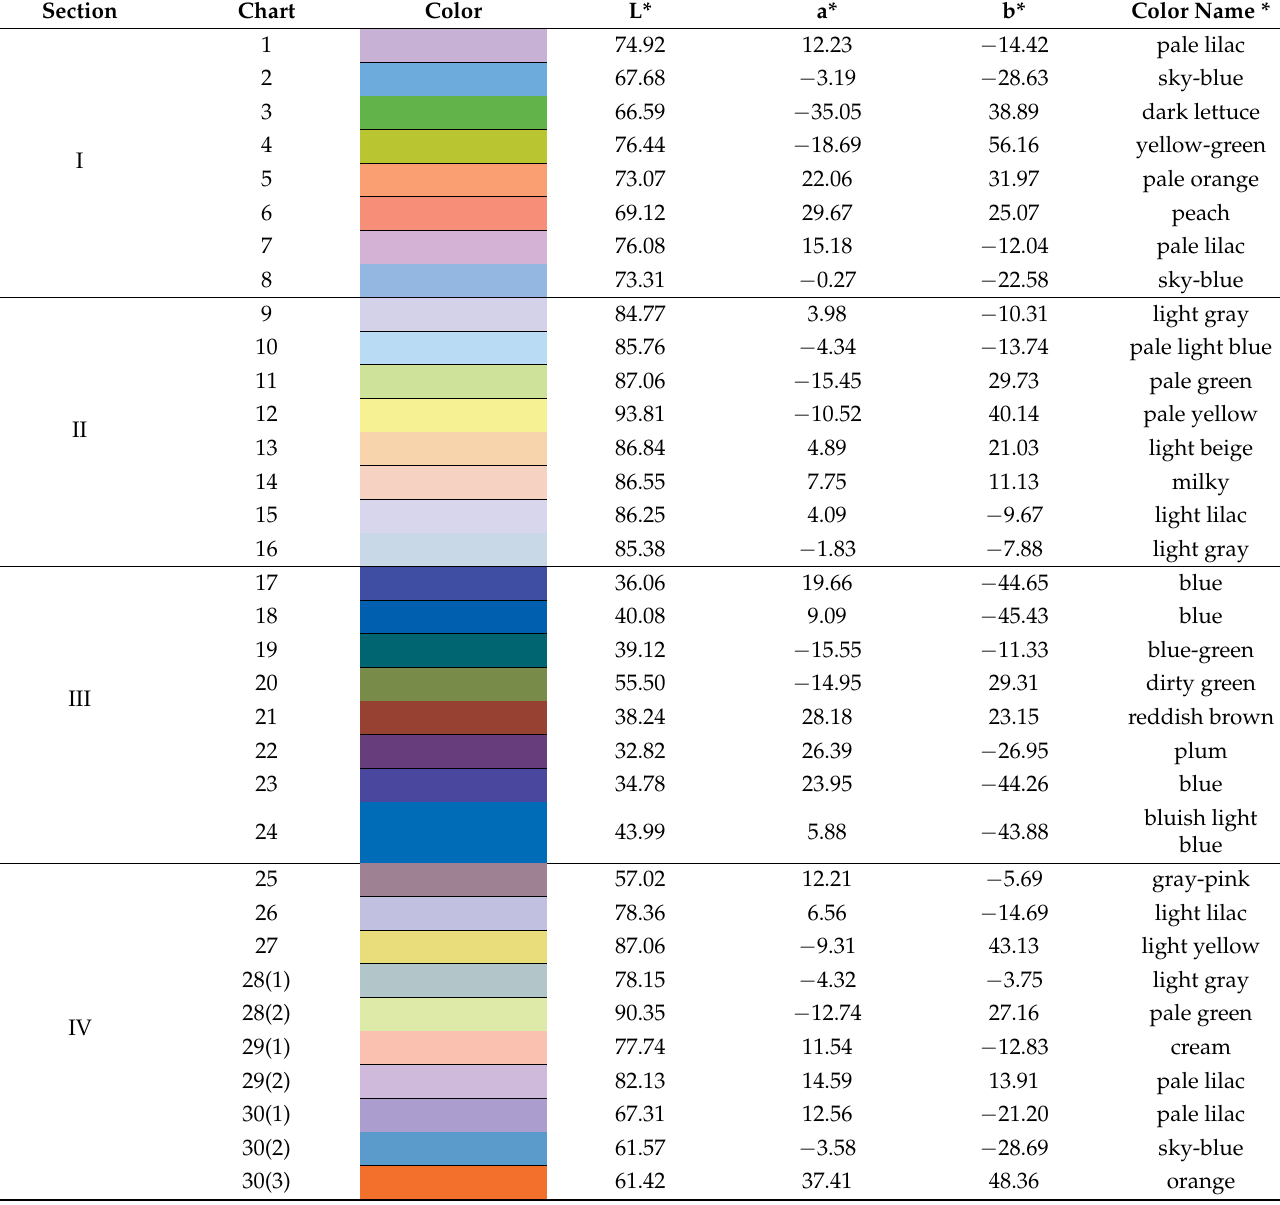
Table 3. “Intermediary”